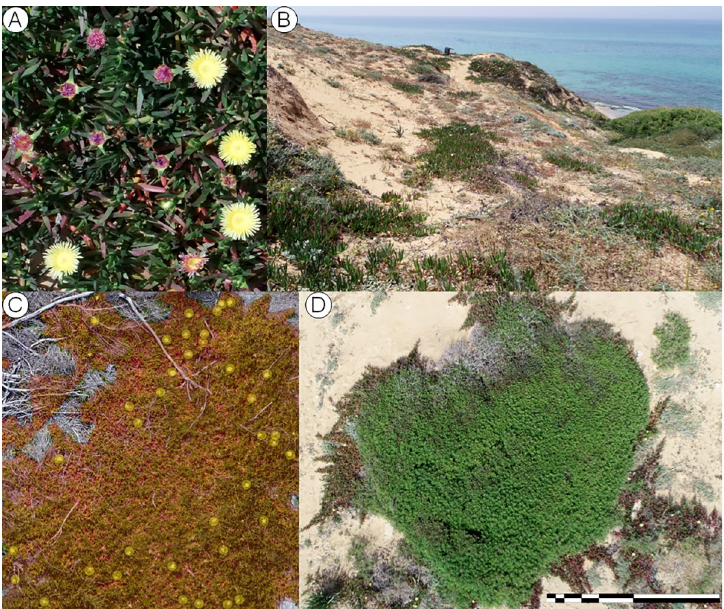
Fig 1. Study site and Carpobrotus spp. ramets. A close-up picture of the Carpobrotus spp. present at the Havatselet field site (a), a wider angle shot of part of the field site (b), polygons overlaid on a Carpobrotus spp. individual after orthomosaicing, as well as a point layer used to count flowers (c), and a single nadir image from the drone–generating the orthomosiac required calibrating 1695 and 1021 nadir images for 2018 and 2019, respectively (d).